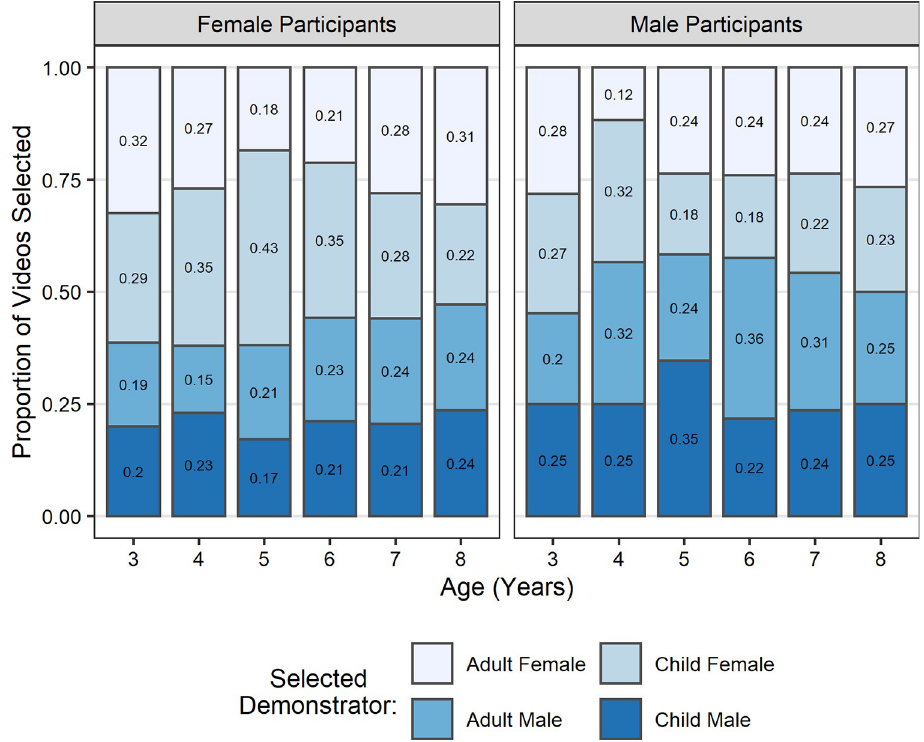
Fig 4. Proportion of selections ( N = 872) of each demonstrator by participant age and gender. Optimal information seeking would have resulted in an equal distribution of selections of each demonstrator. Values presented on bars refer to proportion of selections in each